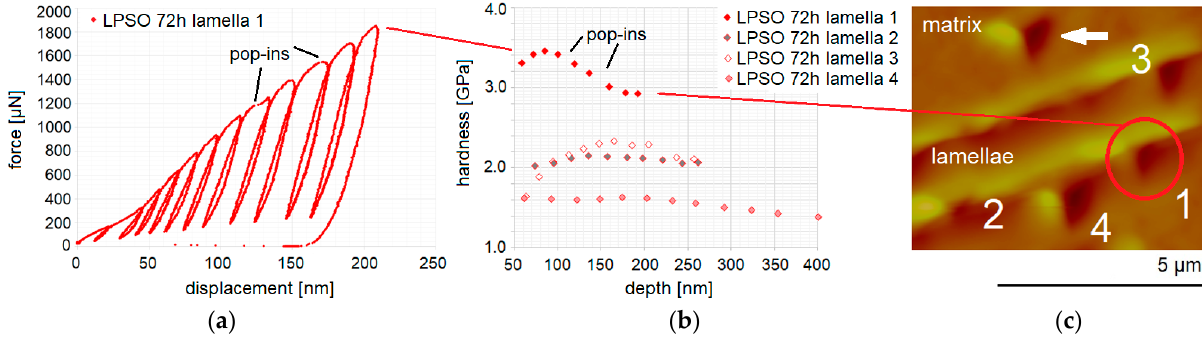
Figure 15. Lamellar LPSO structured region of narrow distance within Mg-matrix after heat treatment of 72 h: force– displacement curve of multi-cycle indent up to 2 mN of LPSO lamella 1 ( a ), its hardness over depth curve with further lamellae 2 to 4 ( b ) and their nanoindenter AFM image, enlarged from Figure 12e ( c ).